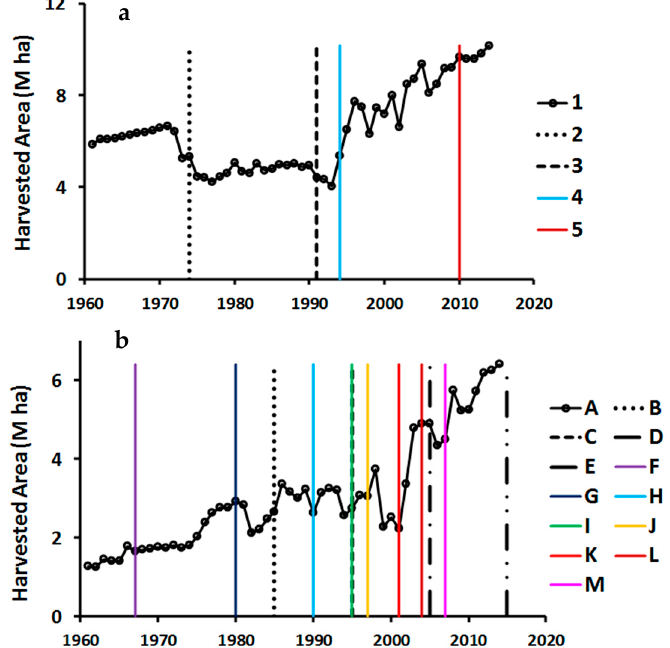
Figure 17. Harvested area time series graphs for ( a ) Ethiopia and ( b ) Tanzania overlaid with institutional change (black lines) and major land reform (colored lines) periods for 1961–2014. Periods are described in Appendix A, Table A1.